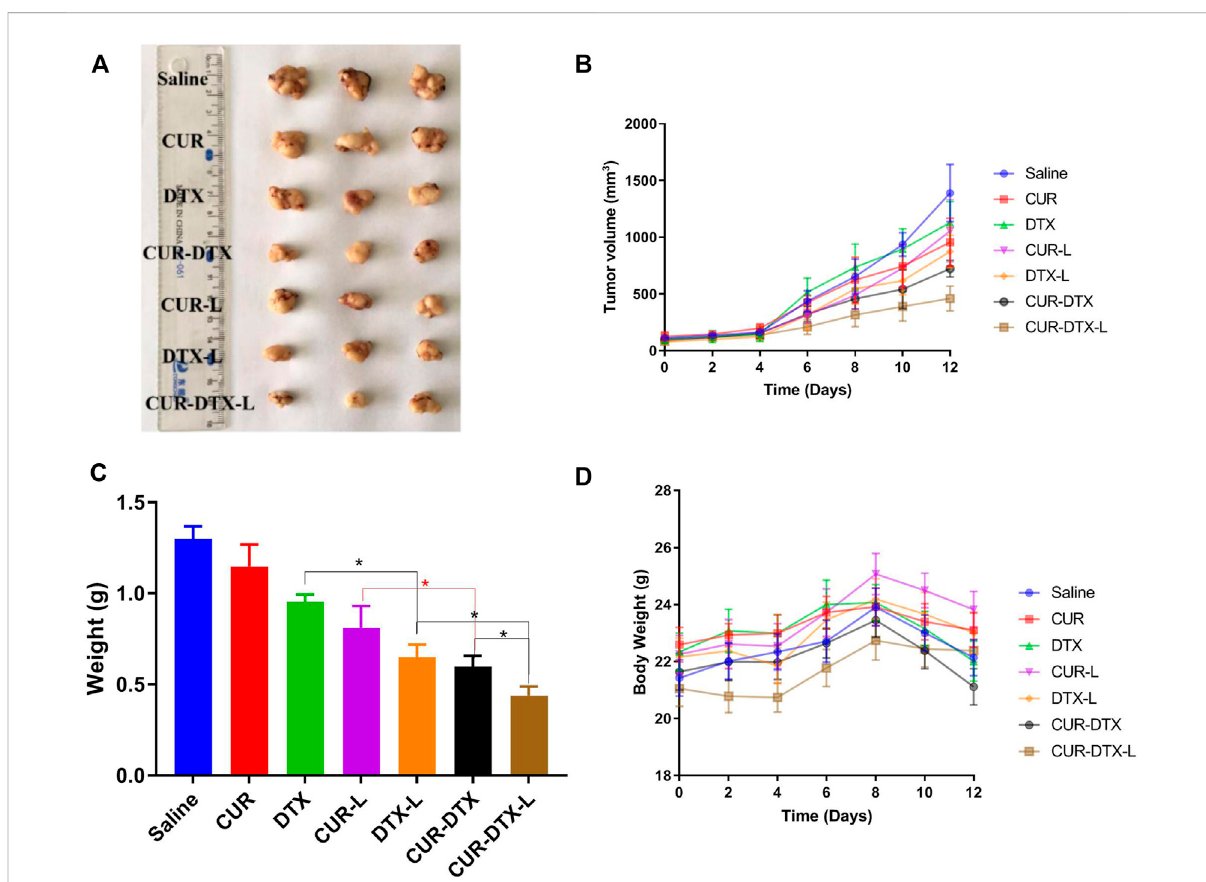
FIGURE 5 Invivo antitumoreffectoftumor-bearingmice treatedwithsaline,CUR,DTX,CUR-L,DTX-L,CUR-DTX,andCUR-DTX-L;* p < 0.05, ** p < 0.01, and n = 3. (A) Tumor images of the different groups; (B) tumor volume curves; (C) weight of excised tumor tissues; (D) body weight changes of different groups during the whole